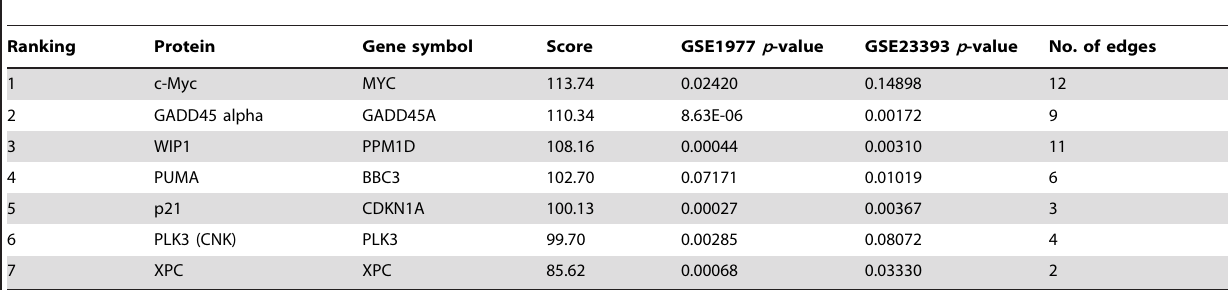
Table 5. The results of the proposed scoring function test applied to the network in Figure